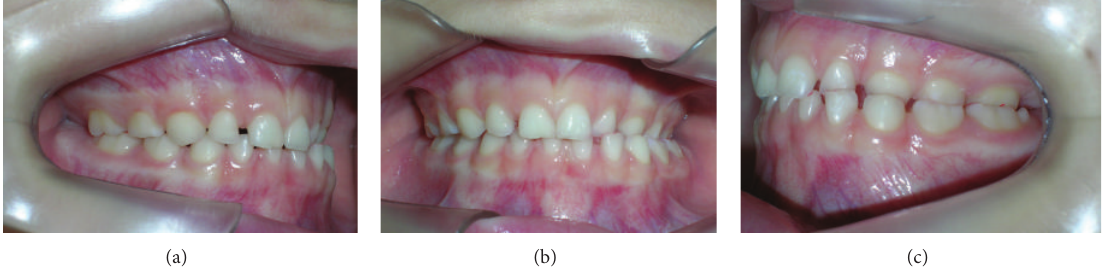
Figure 1: Clinical aspects in centric position. (a) Right side, (b) frontal view, (c) left side.